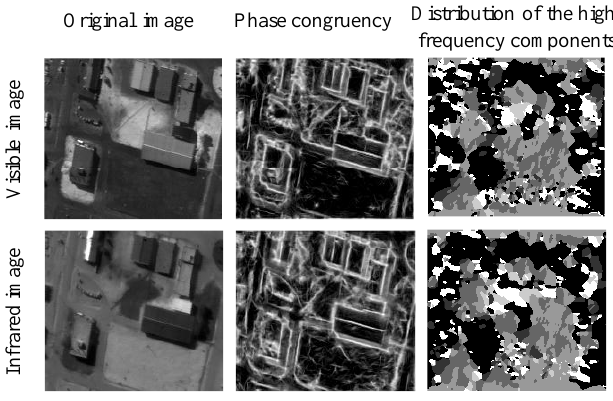
Figure 1. Comparison between phase congruency and the distribution of the high-frequency components.